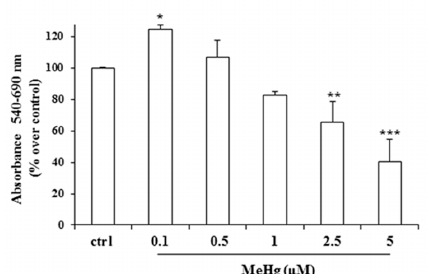
Figure 1. Effects of short treatment with methylmercury (MeHg) on cell viability. Nthy-ori-3-1 cell viability was measured by MTT assay after 24 h of treatment with various concentrations of MeHg. Results are expressed as percentage of increment vs. untreated cells, representing the mean ± SD of three independent experiments. Statistical analysis was performed using the Tukey – Kramer multiple comparisons test. * p < 0.05, ** p < 0.01, *** p < 0.001, vs. untreated cells (control).